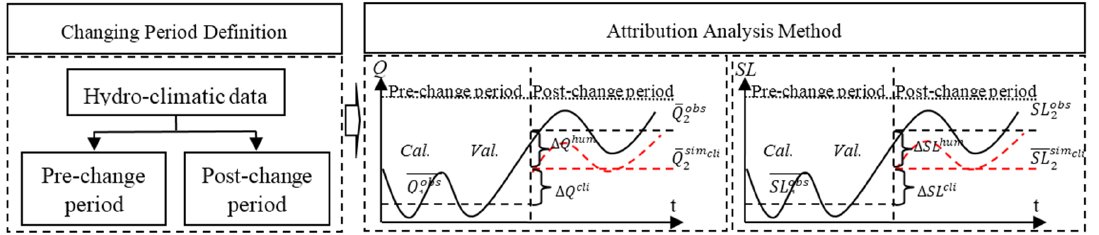
Figure 2. Different period separation and schematic diagram of Δ Q, Δ SL.